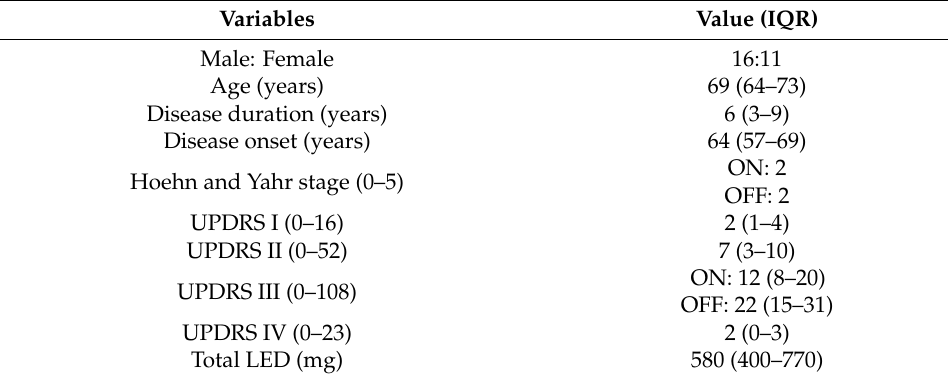
Table 1. Demographics and clinical characteristics of PD patients.